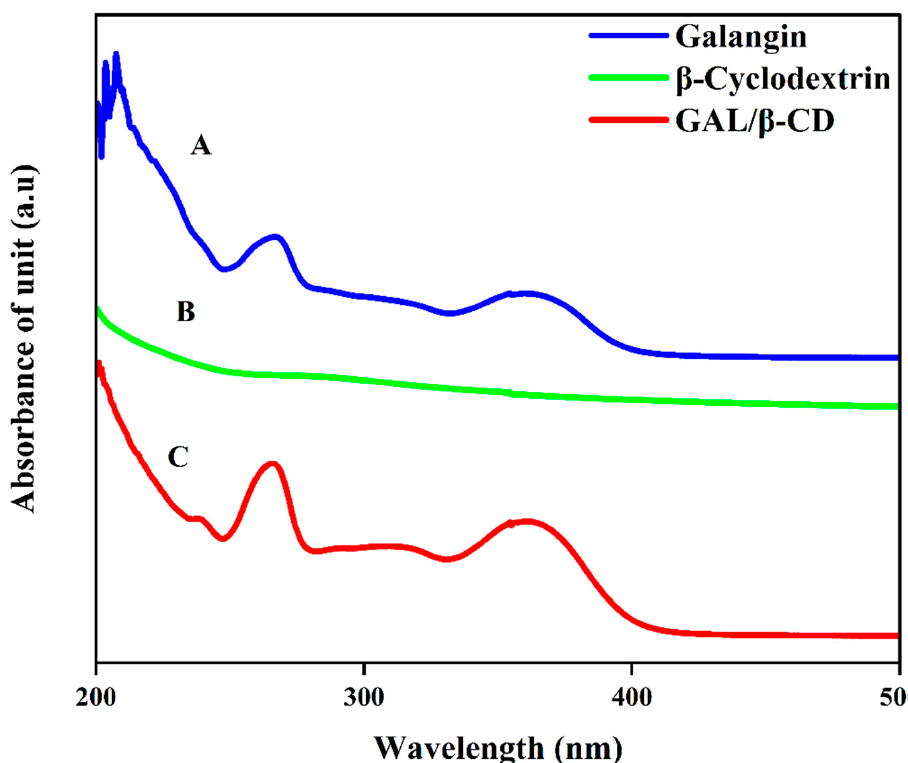
Figure 3. UV–vis spectroscopic analysis of ( A ) pure galangin, ( B ) β -cyclodextrin, and ( C ) GAL/ β - CD.